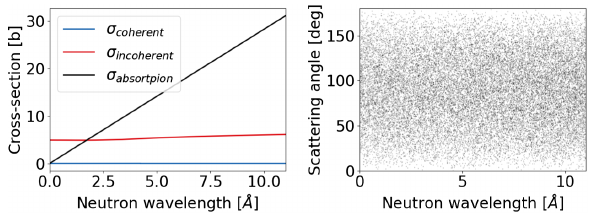
FIG. 2. Neutron scattering on 51 V, data from NCrystal [18,19]. nat V contains99.75%of 51 V.Left:Cross sectionversuswavelength. Right: Scattering angle as a function of wavelength. The lack of features in the scatter plot indicates an isotropic phase